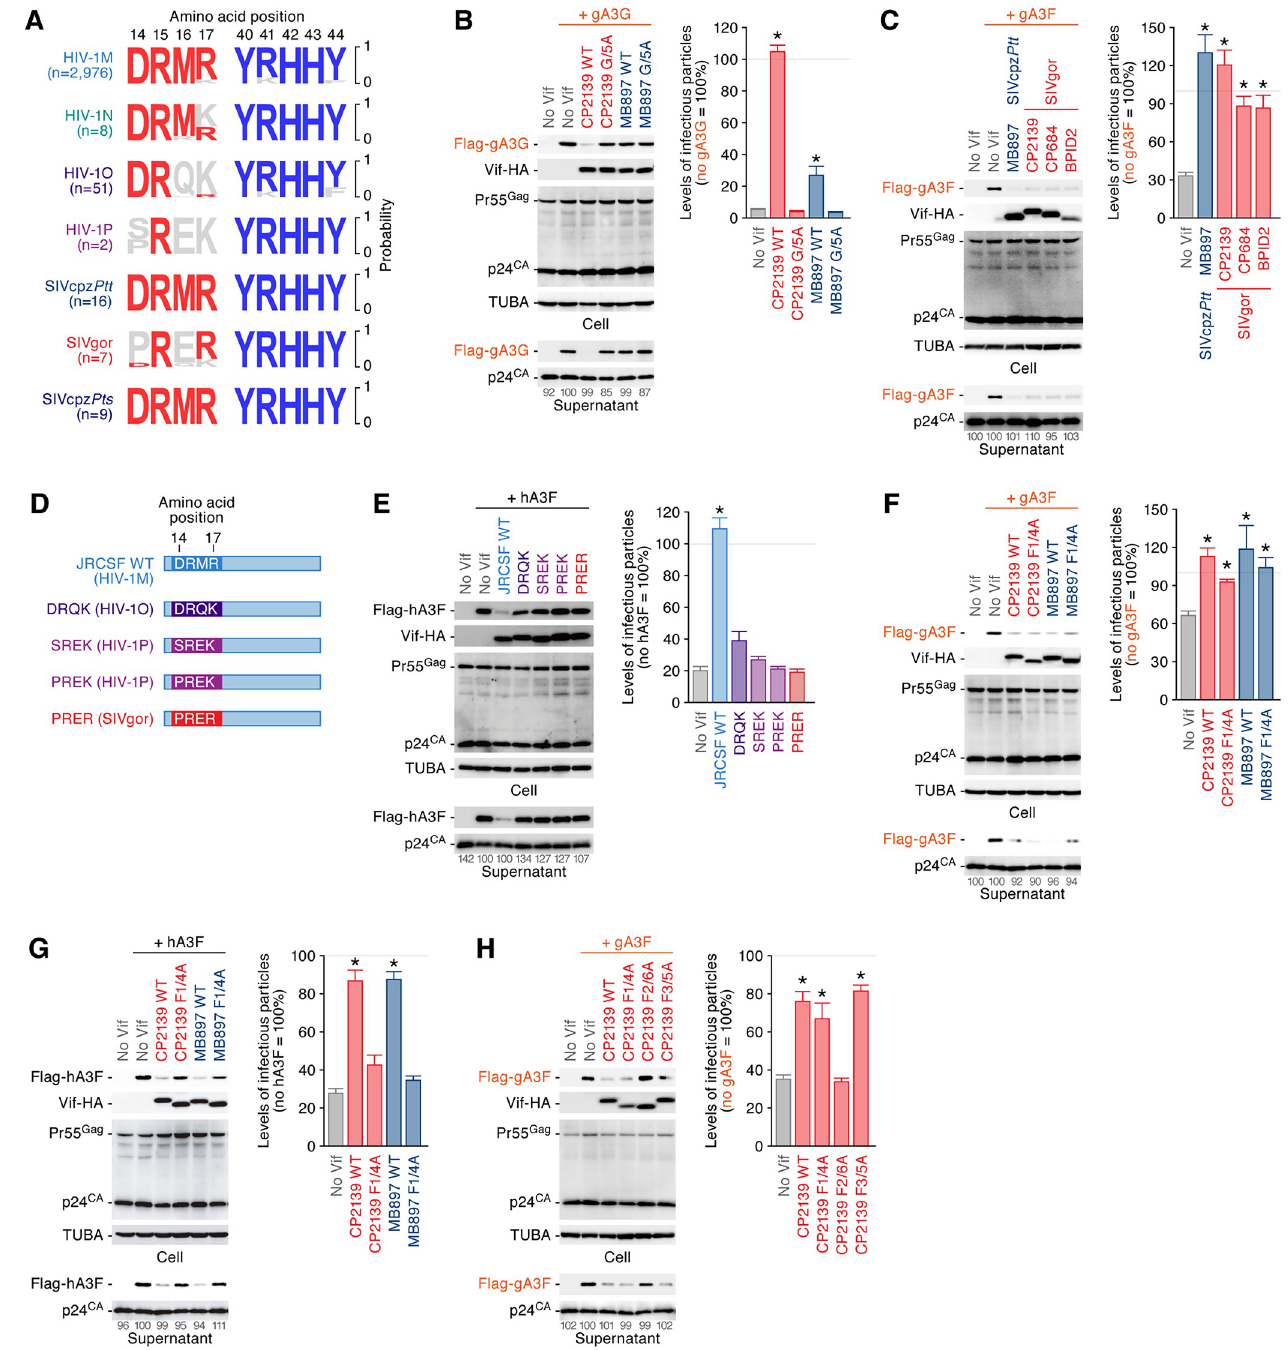
Fig 4. Counteraction of antiviral gA3F by SIVgor Vif independently of the F1 and F3 boxes. (A) Loss of F1 box in SIVgor, HIV-1O and HIV-1P Vif. Logo plots of the Vif residues between 14–17 (corresponding to the F1 box in HIV-1M; left) and the residues between 40–44 (corresponding to the G box in HIV- 1M; right) in HIV-1MNOP, SIVcpz and SIVgor are shown. The number in parenthesis (n) indicates the number of viral sequences used in this analysis. (B and C) Counteracting activity against gA3G and gA3F. HEK293T cells were co-transfected with pNL4-3 Δ vif (500 ng) and the expression plasmids for either gA3G (50 ng, B) or gA3F (200 ng, C) and indicated Vif (500 ng). (D) Scheme of HIV-1M JRCSF Vif derivatives used in this study. (E) Counteracting activity against hA3F. HEK293T cells were co-transfected with pNL4-3 Δ vif (500 ng) and the expression plasmids for hA3F (50 ng) and indicated HIV-1M JRCSF Vif derivatives (500 ng). (F-H) Counteracting activity of SIVgor and SIVcpz Vif against great ape A3F. HEK293T cells were co-transfected with pNL4-3 Δ vif (500 ng) and the expression plasmids for either gA3F (F, 200 ng) or hA3F (G, 50 ng) and indicated Vif (500 ng). In B, C, and E-H, cells and supernatants were harvested at two days post-transfection and were used for Western blotting and TZM-bl assay. For Western blotting, the input of cell lysate was standardized to